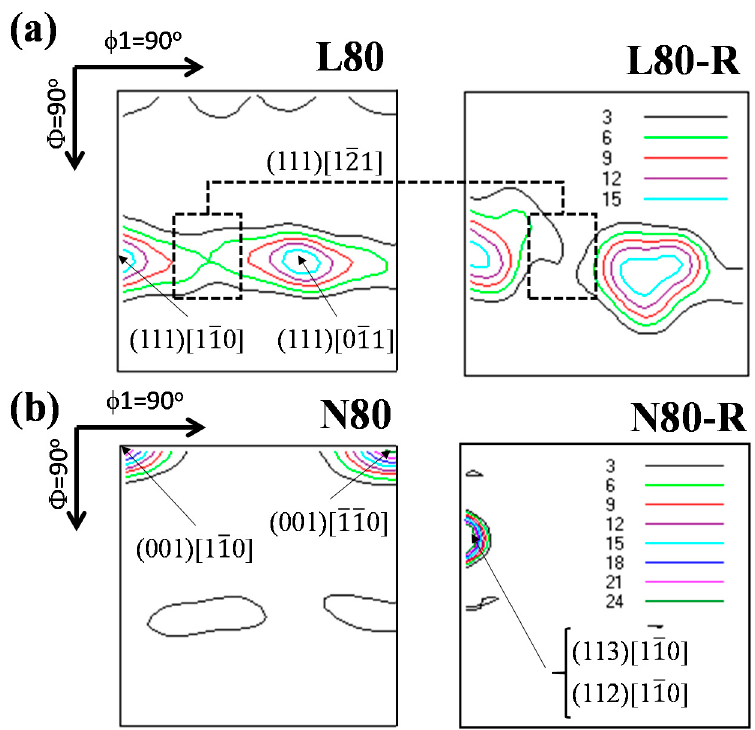
Figure 5. φ 2 = 45 ◦ section of ODF for ( a ) L-Sample with 80% compression ratio, and ( b ) N-sample with 80% compression ratio. Before (L80 and N80, respectively) and after recrystallization (L80-R and N80-R, respectively). The major texture components are indicated.